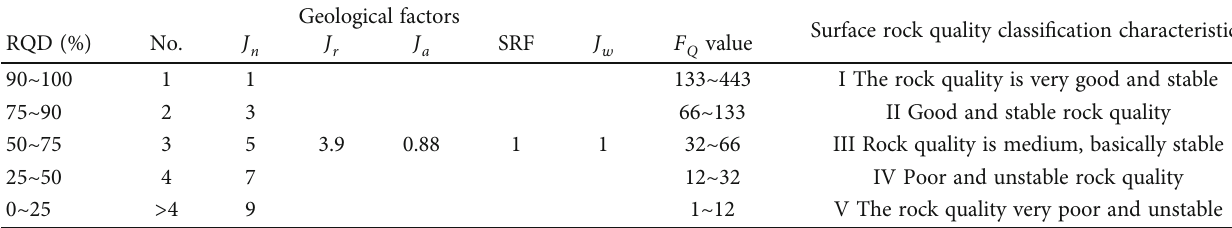
Q for rock mass